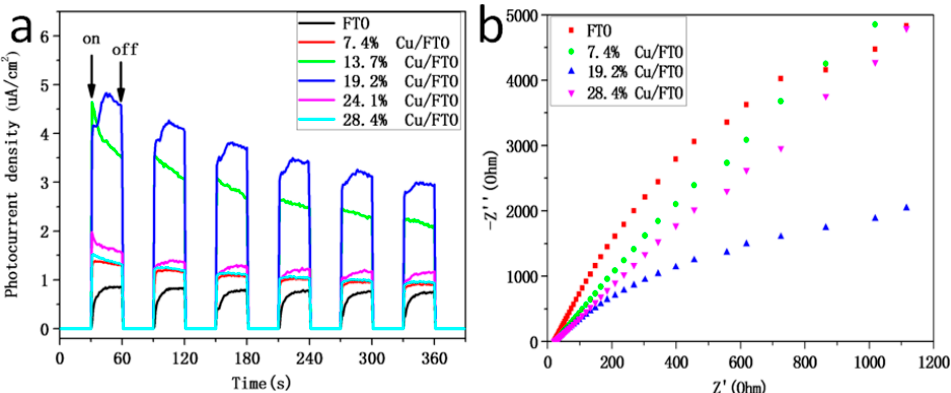
Figure 8. ( a ) The transient photocurrent of FTO and Cu/FTO samples with different contents of Cu and ( b ) EIS (electrochemical impedance spectra) Nyquist plots of FTO and Cu/FTO samples with different contents of Cu under visible light irradiation.